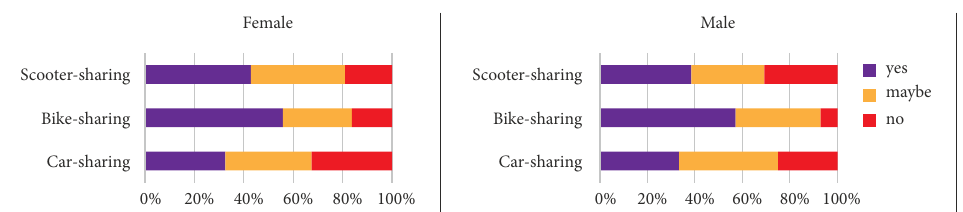
Figure 4. Distribution of tourists answers whether they would use a sharing system at the resort by the type of transport mode and by gender